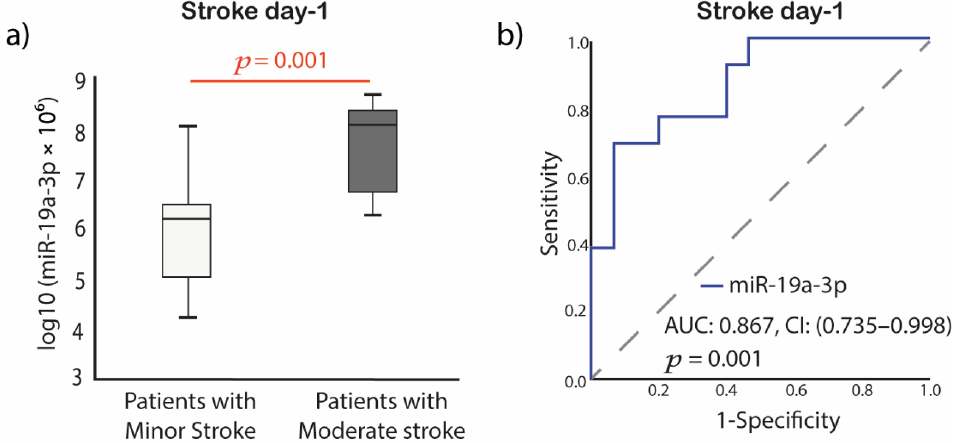
Figure 7. MiRNAs expression difference based on stroke severity at the day of stroke. ( a ) miR-19a- 3p box plots; ( b ) miR-19a-3p ROC curves for prediction of stroke severity. The initial stroke severity as measured by the NIHSS at admission. Minor stroke: 1–4 ( n = 15) and moderate stroke: 5–15 ( n = 13). Abbreviations: log10, log10 transformation; miR, microRNA; p , value; AUC, area under the curve; CI, confidence interval; ROC, Receiver operating characteristic; NIHSS, National Institutes of Health Stroke Scale.